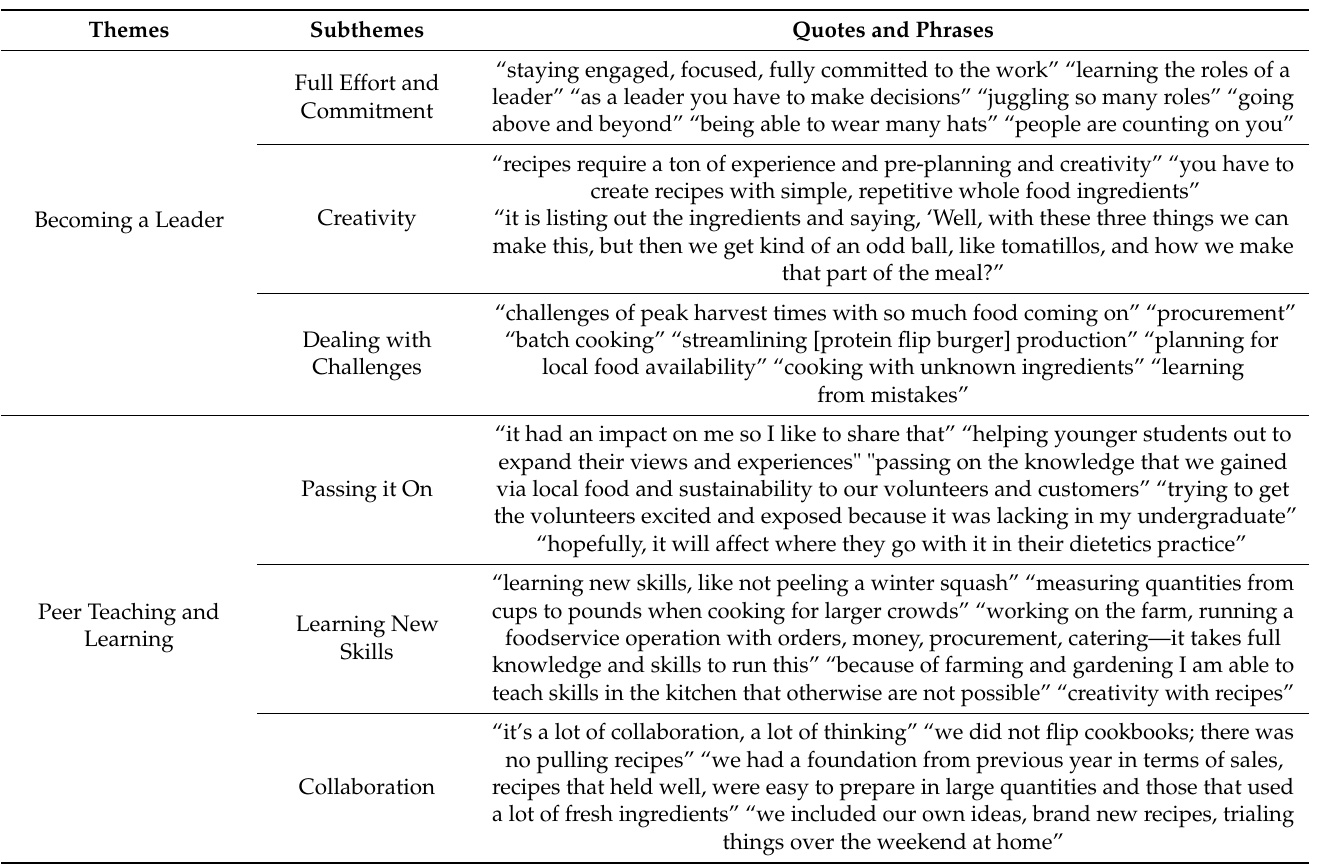
Table A4. Visual data display of themes, subthemes, and representative quotes of leads’